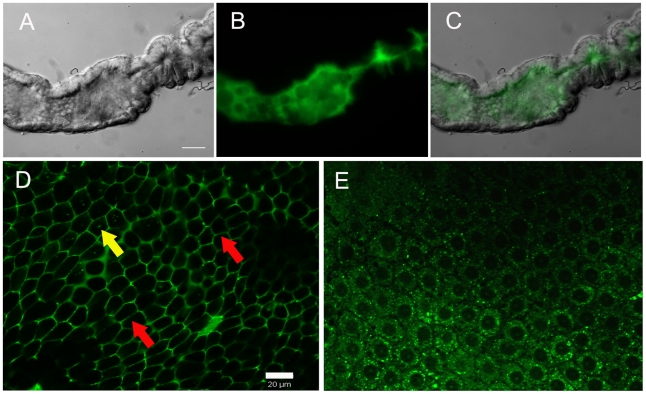
Sites of ROS location in the midgut epithelia.Midguts were incubated with CM-H2DCFDA (2 µM) for 20 min, washed and visualized under an epifluorescence (A–C) or confocal microscope (D–E). (A) DIC image of sugar-fed midgut. Scale bar– 100 µm. (B) ROS staining of midgut in (A). (C) Merge of (A) and (B). (D) Confocal image of epithelia from sugar-fed or (E) blood-fed (24 hrs) females showing different patterns of ROS production. Scale bar – 20 µm. The fluorescence intensity is not directly comparable in the images shown in panels D and E because the microscope was set to acquire the best image under each condition to allow optimal visualization of cellular ROS production sites. Red arrows indicate fluorescence associated with the cell periphery. Yellow arrows indicate fluorescence associated with intracellular organelles.